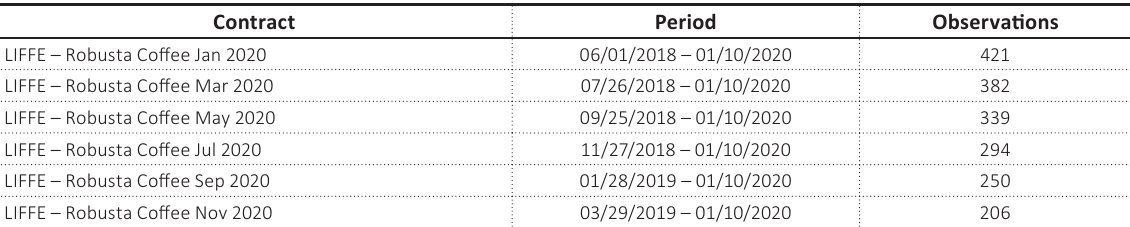
Source: Authors’ calculations based on Thomson Reuters Datastream.